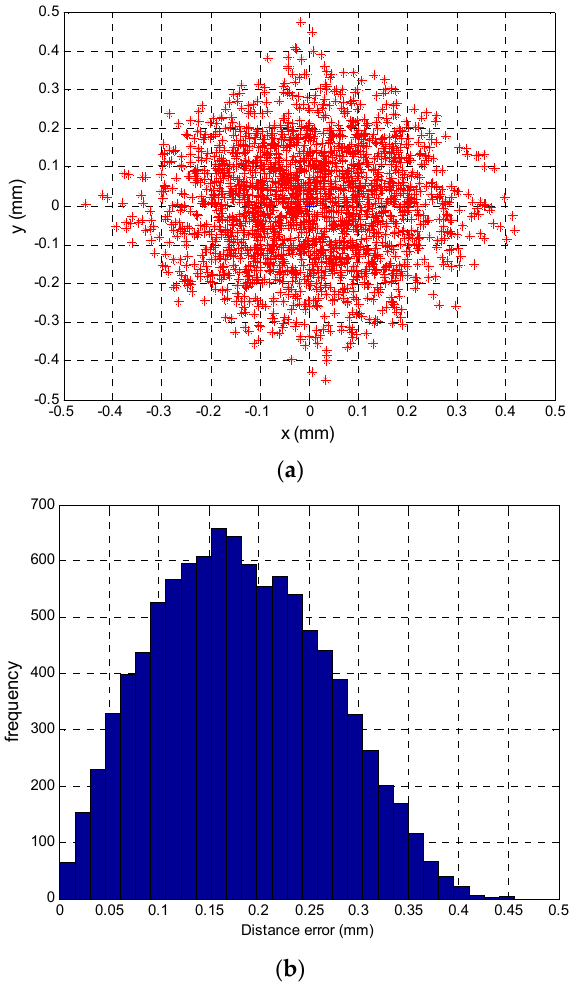
Figure 7. ( a ) Enlarged central point, ( b ) Distribution of distance error from the central point.